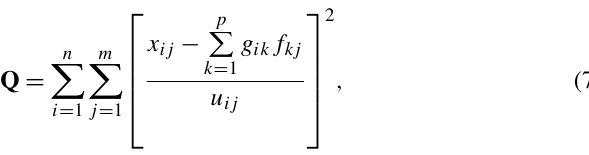
higher after the background values were deducted. The re- sults suggested that air masses at MK were dominated by fresh